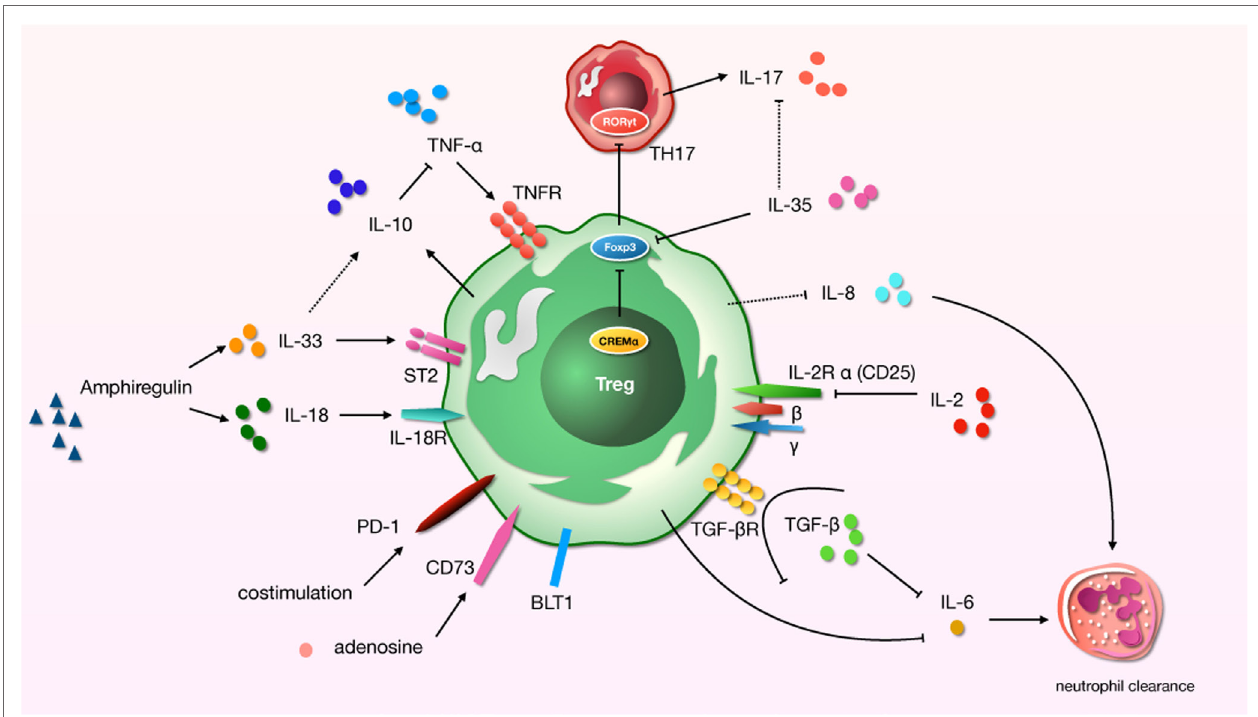
FiGURe 1 | A schematic about regulatory T cells (Tregs)-related cytokines and immunosuppressive molecules in acute lung injury (ALI) process. “ → ”: promote; “ ⊥ ”: inhibit; “ ⋯ ”: may play a